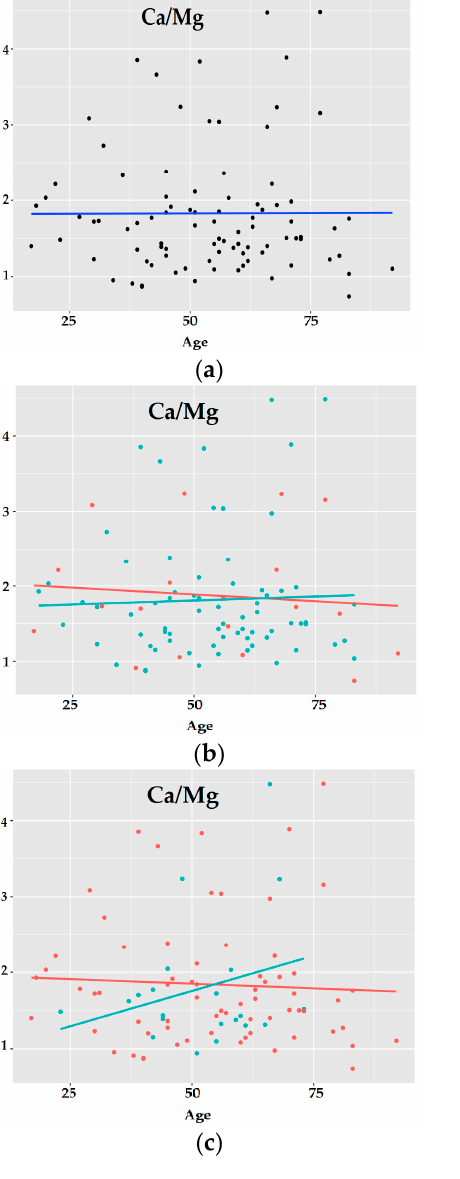
Figure 8. The trends of changes for Ca/Mg and Na/K ratios with age for all 187 subjects ( a , d ) (back points, blue line); males (green points, green line) and females (red points, red line) ( b , e ); AUD subjects (green points, green line) and the subjects without AUD (red points, red line) ( c , f ).